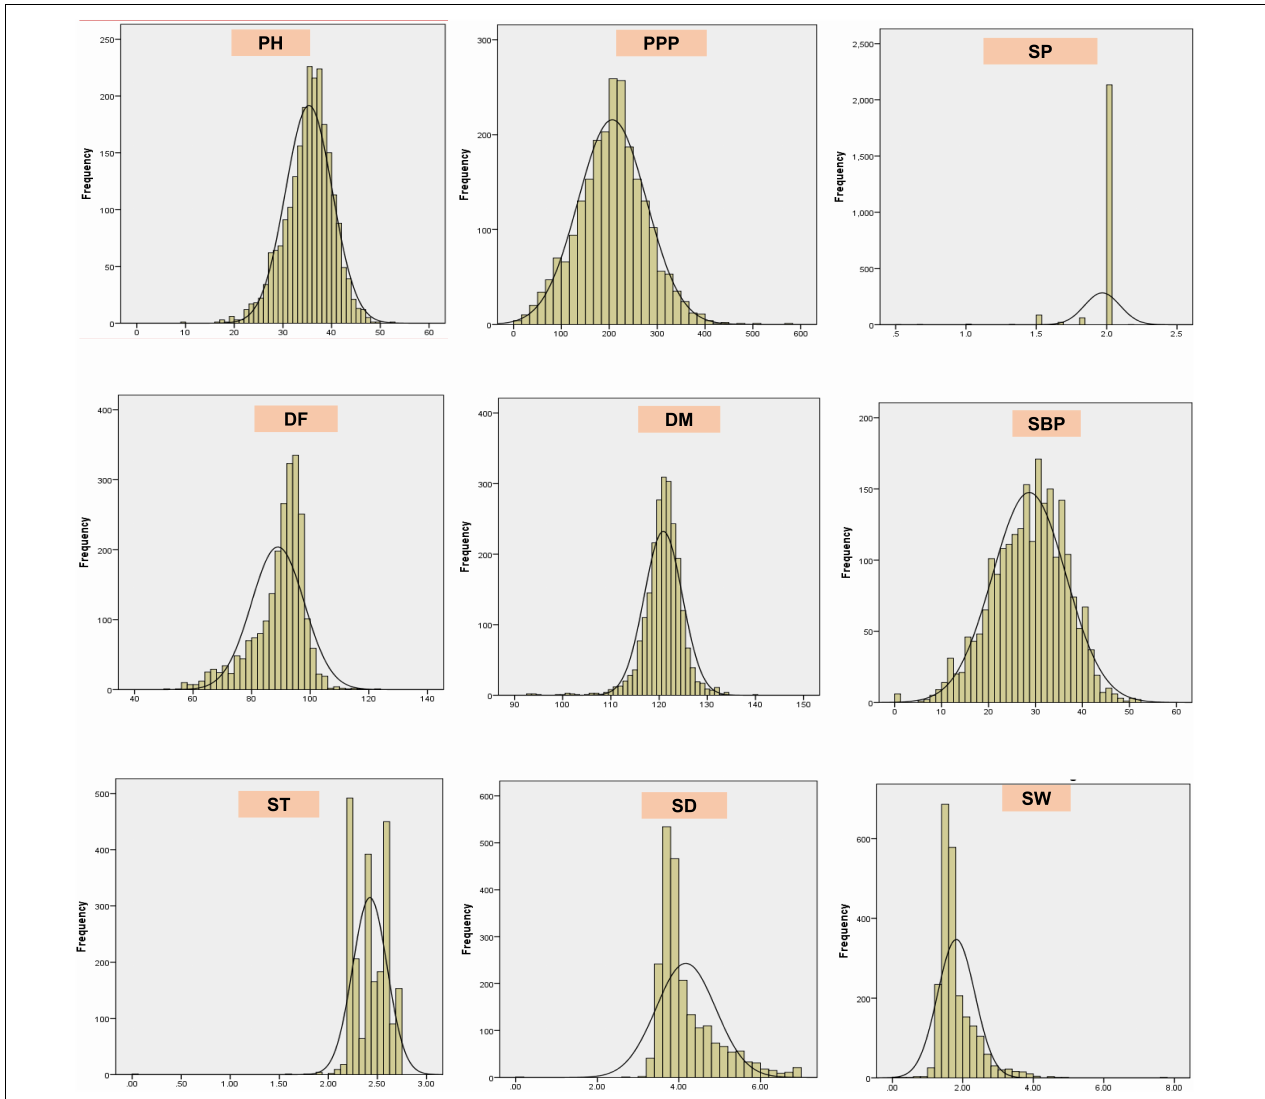
FIGURE 5 | Frequency distribution plots showing the variability of nine quantitative traits in the entire lentil germplasm conserved in Indian national